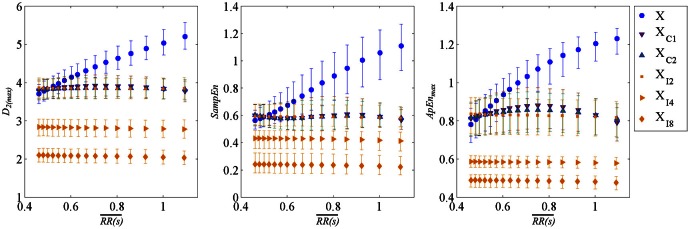
Non-linear HRV indices computed from simulation study varying mean heart period, distribution of all uncorrected nonlinear HRV indices are shown in (blue) circles, corrected by linear regression in (brown) down triangles, corrected by parabolic regression in (green) up triangles, both former cases only subject-specific correction value of non-linear indices for each RR were shown. Finally, HR-corrected non-linear indices by interpolating RR time series at 2, 4, and 8 Hz in (orange) diamonds. Data corresponds to all simulations derived from Fantasia database. Distributions are represented by median and interquartile range.